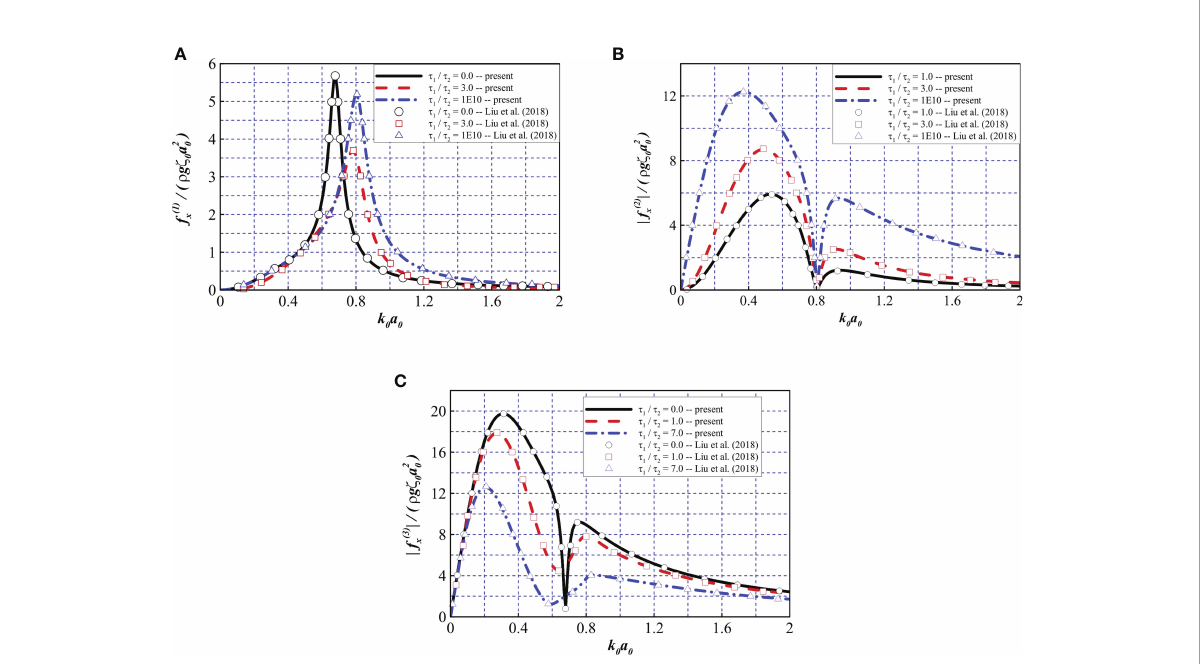
FIGURE 5 Comparison of the dimensionless force to the results derived by Liu et al. (2018). Force (A) on the wind turbine tower, (B) on the interior net, and (C) on the exterior